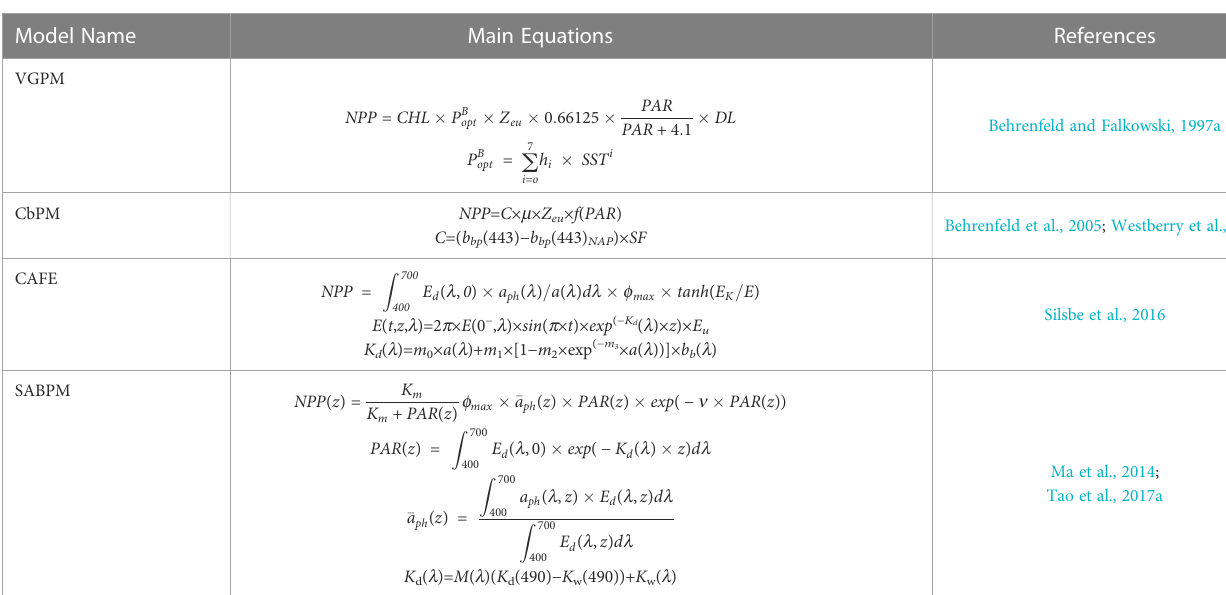
TABLE 1 The main equations of NPP